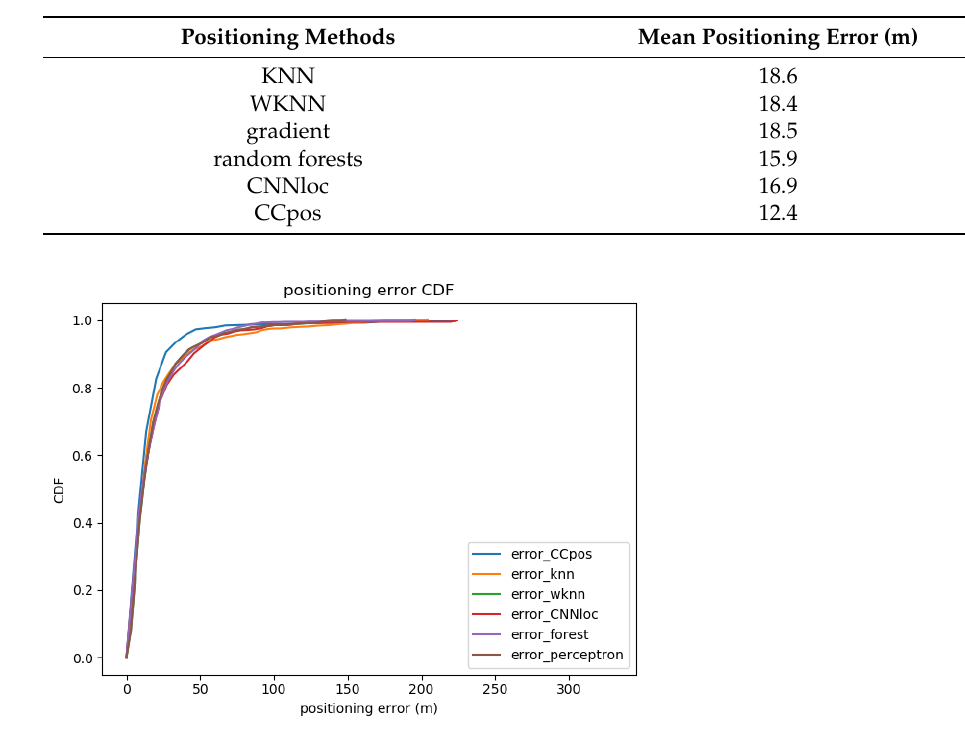
Table 10. Mean positioning error with different methods on the UJIIndoorLoc dataset.